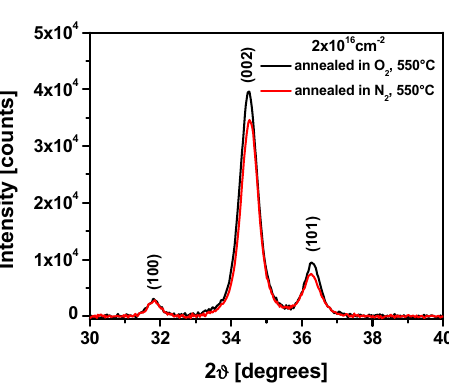
Fig. 2. X-ray diffraction patterns of ZnO:Ga films implanted with 2 × 10 16 cm − 2 , annealed in O 2 at 550 ◦ C for 30 min and N 2 at 550 ◦ C for 10 s.